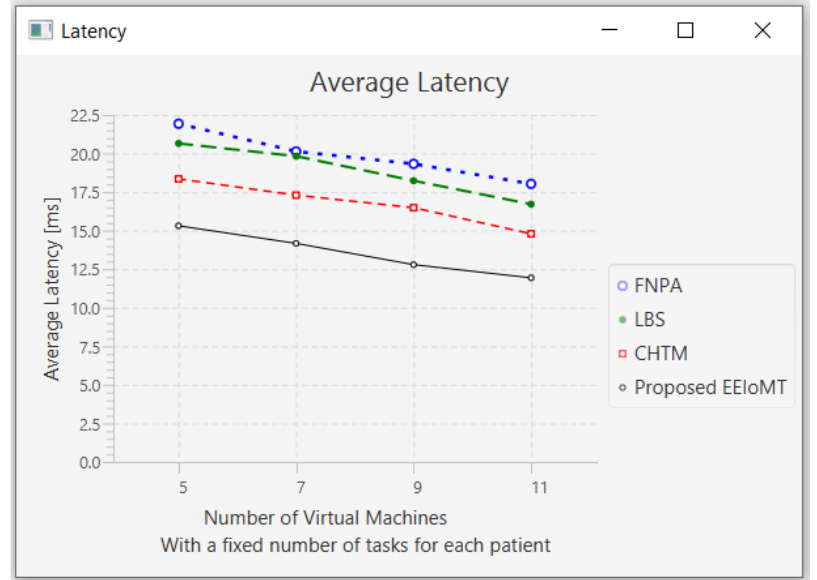
Figure 16. Average latency comparison when changing the number of VMs.